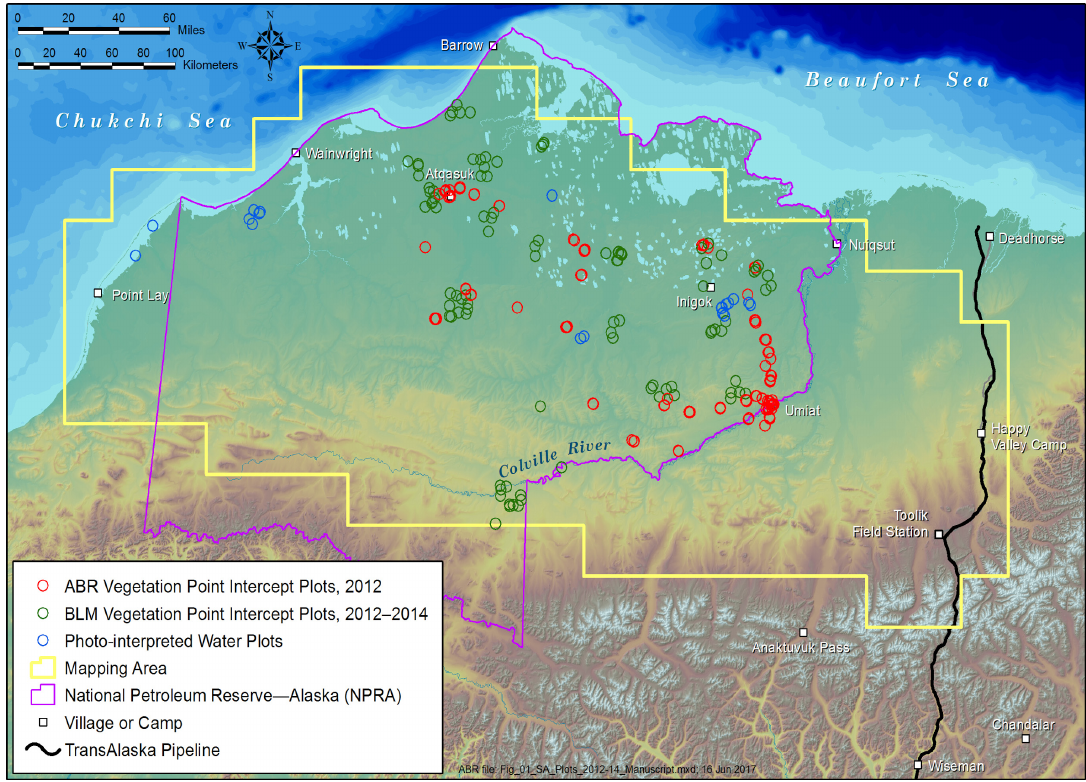
(Table 1). The nine PFTs were defined by growth form and leaf habit: tall deciduous shrub (>1.5 m height), low deciduous shrub (0.2–1.5 m), dwarf deciduous shrub (<0.2 m), dwarf evergreen shrub, sedge, grass, forb, moss and lichen; we also mapped five aggregate PFTs in which similar PFTs were combined (e.g., total shrubs, total herbaceous).